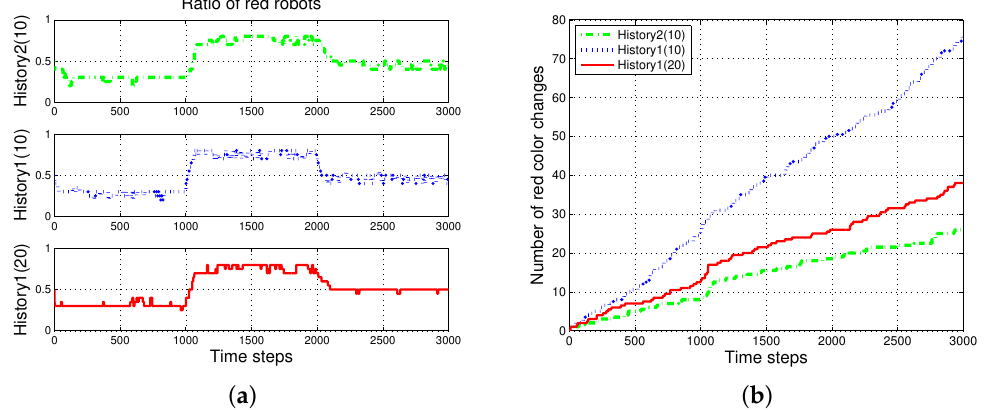
Figure 9. Comparison results of History 1 ( L = 10 ) , History 1 ( L = 20 ) and History 2 ( L = 10 ) . The numbers in parentheses refer to the length of the puck history. ( a ) Ratio of red robots in a group; ( b ) number of red color changes.